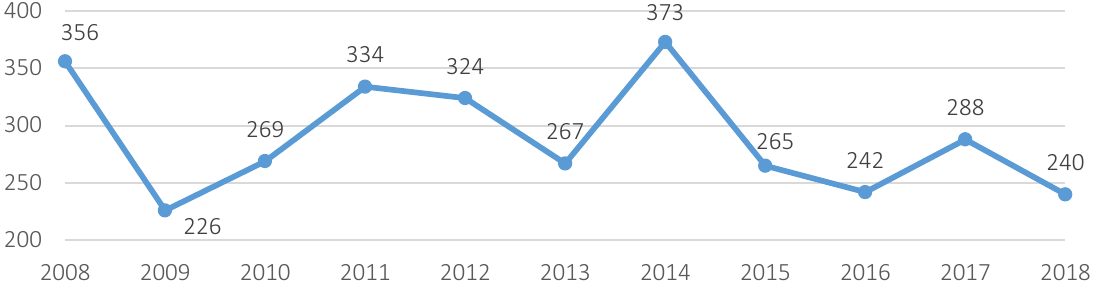
Figure 7. The area of residential buildings commissioned in Odesa region in 2008–2018,